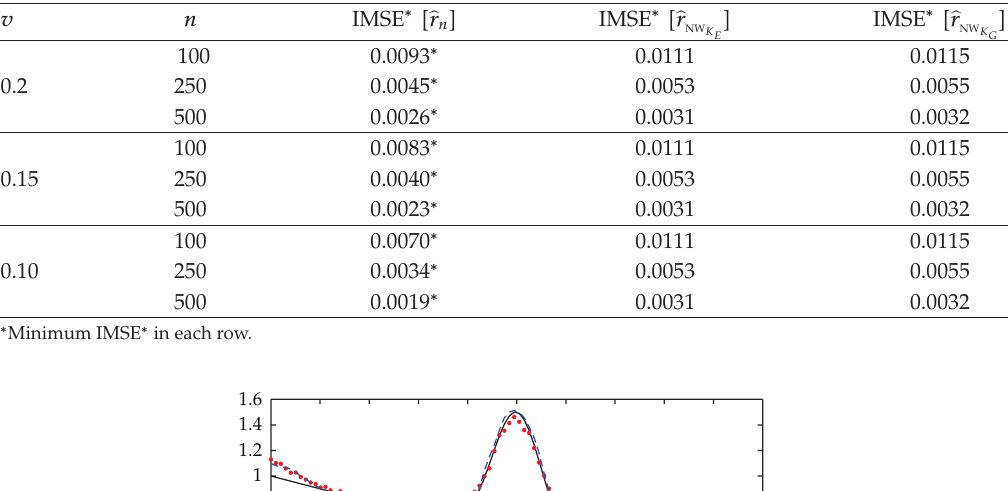
Table 1: IMSE ∗ values of the estimations for the fuzzy set estimator and the kernel estimators.